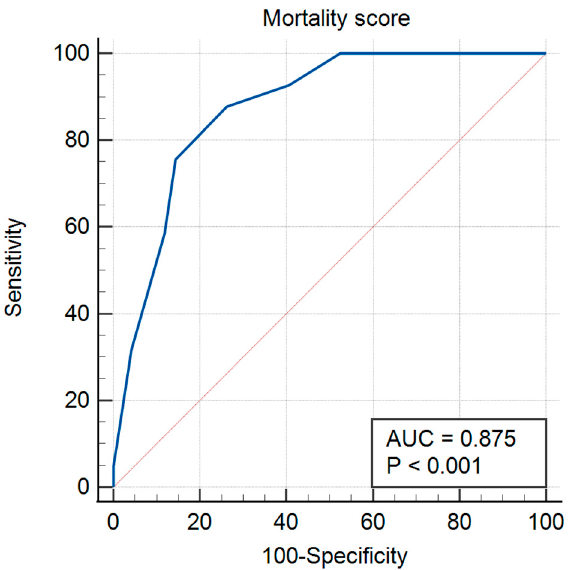
Figure 2. Receiver-operating characteristics (ROC) analysis of the mortality score. Abbreviations: AUC, Area under the curve.